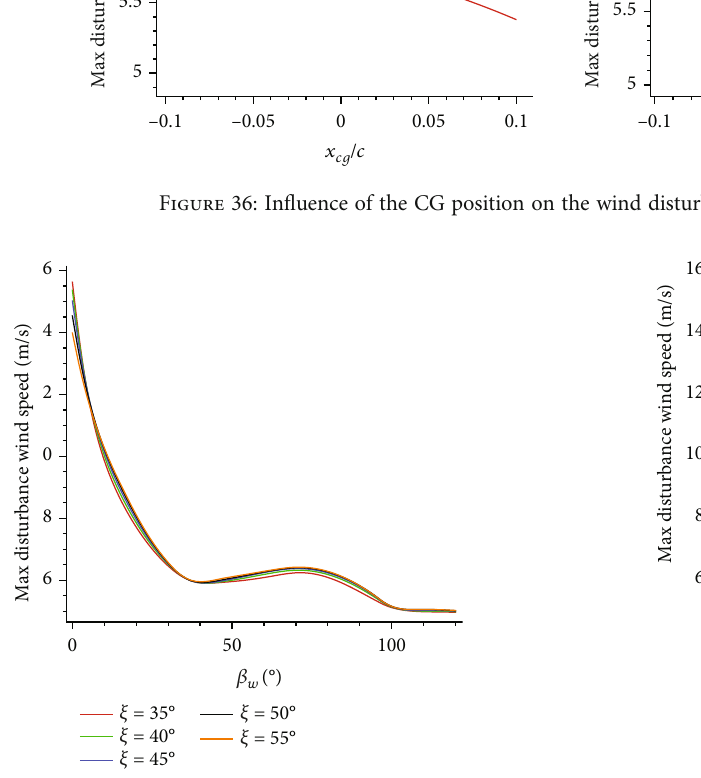
Figure 37: In fl uence of the ξ on the wind disturbance rejection performance.